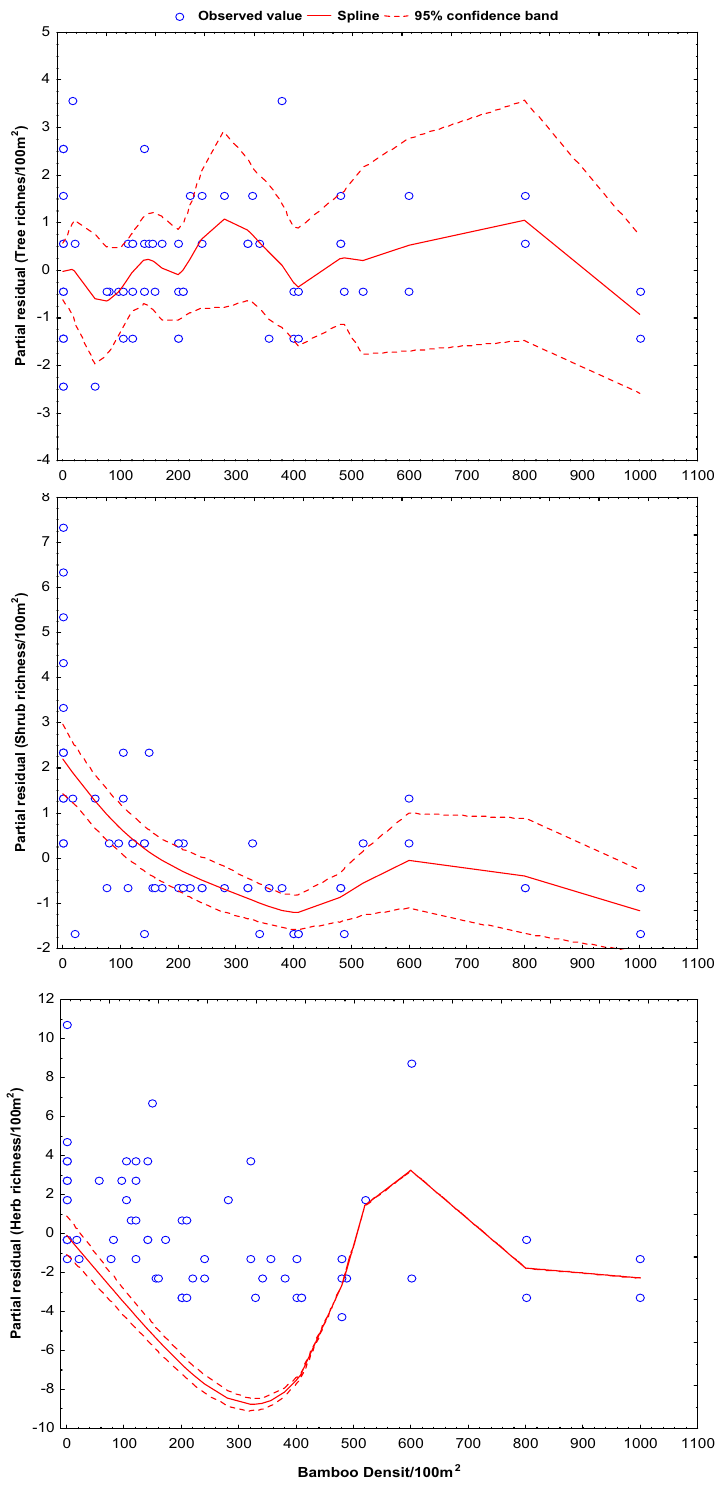
Figure 1. Predicted changes in species richness of trees, shrubs and herbs with respect to increasing density of bamboo. The significance of the smooth best fit model generalized the changing slope as GAM coefficient (β), standard error (SE) and coefficient of determinant (R 2